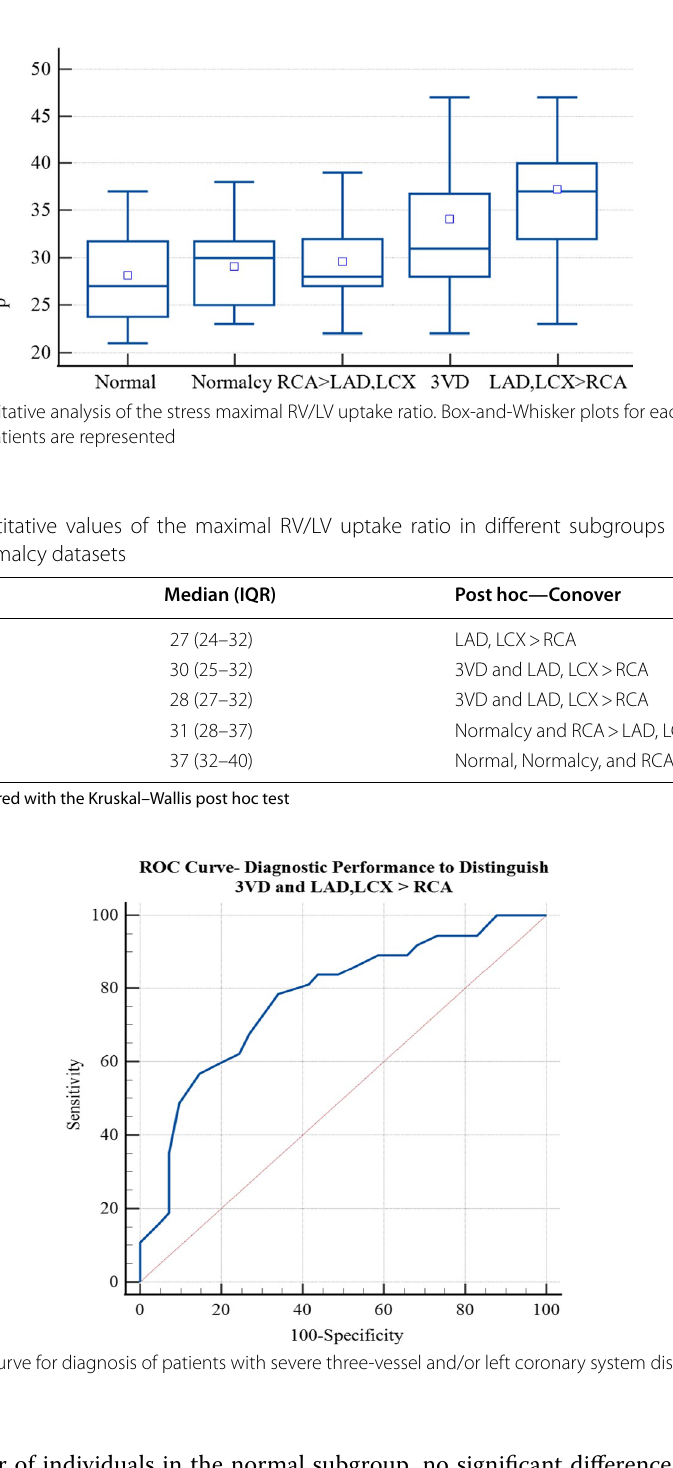
small number of individuals in the normal subgroup, no significant difference was dis- covered between the normal and 3VD subgroups.